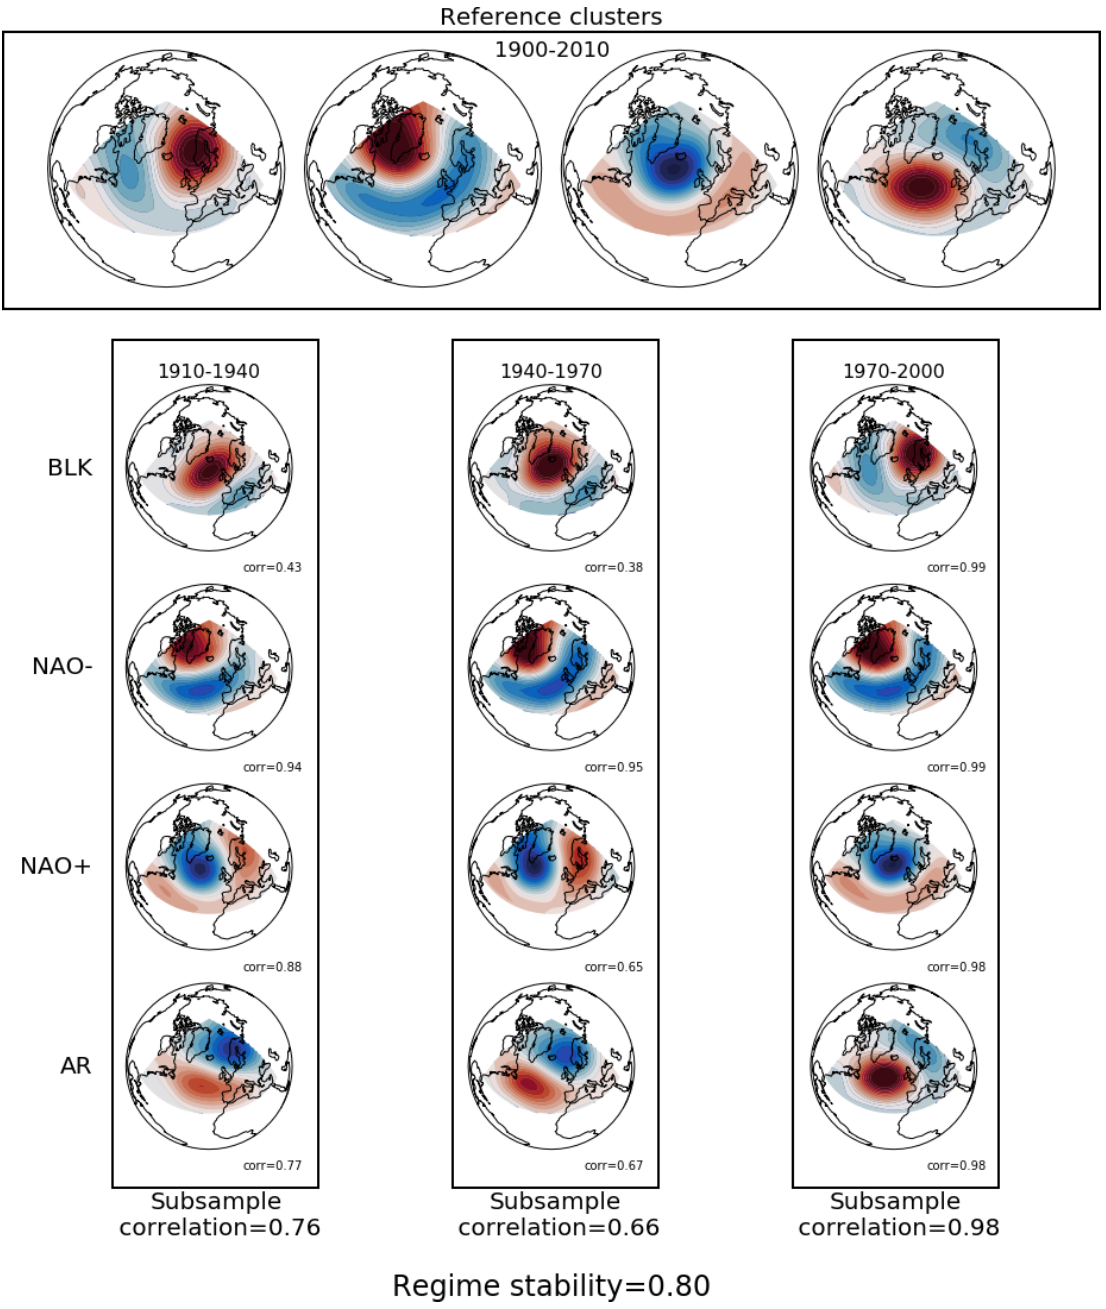
Figure 3. A schematic highlighting how regime stability is calculated, shown for four classical circulation regimes found in ERA20C. Reference regimes are obtained from the full length of the dataset, in this case 110 DJF seasons. Regimes are also calculated for a number of subsamples of the dataset covering different time periods, and the regime patterns are mapped to the reference regime with which they have the highest pattern correlation. These correlations are then averaged across regimes and subsamples to give an average measure of regime stability. Note that while only three independent subsamples are shown here in this illustrative schematic, overlapping time periods are used in practice to increase the number of